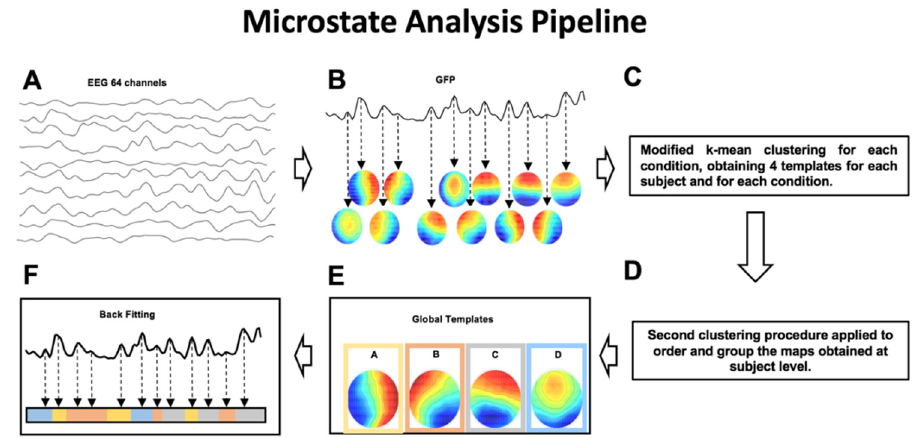
Figure 1. ( A , B ) Step 1: The intervals of stable topographical configurations are identified. ( C – E ) Step 2: The global templates of the dominant microstates are calculated for the identified intervals of brain functional stability. ( F ) Step 3: The identified global templates are backfitted to each noise-free EEG dataset to find the specific sequence of microstates on which metrics are calculated.